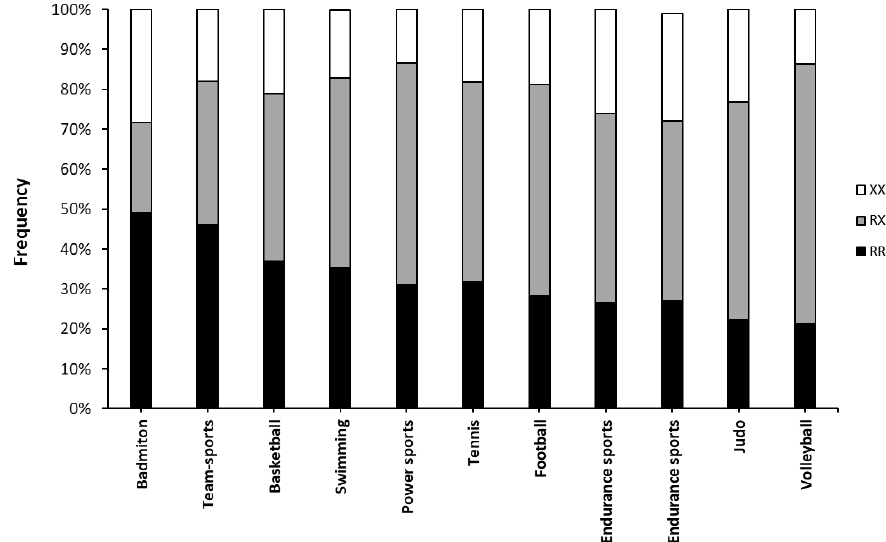
Figure 2. Frequencies of ACTN3 genotypes in samples of European professional athletes. Data have been obtained from Eynon et al. [23] for team sports, from Garatachea et al. [21] for basketball, from Ruiz et al. [16] for swimming, from Eynon et al. [32] for power sports, from Moreno-Perez et al. [20] for tennis, from Del Coso et al. [38] for football, from Eynon et al. [32] and Lucia et al. [14] for endurance sports, from Rodriguez-Romo et al. [39] for judo and from Ruiz et al. [40] for volleyball.